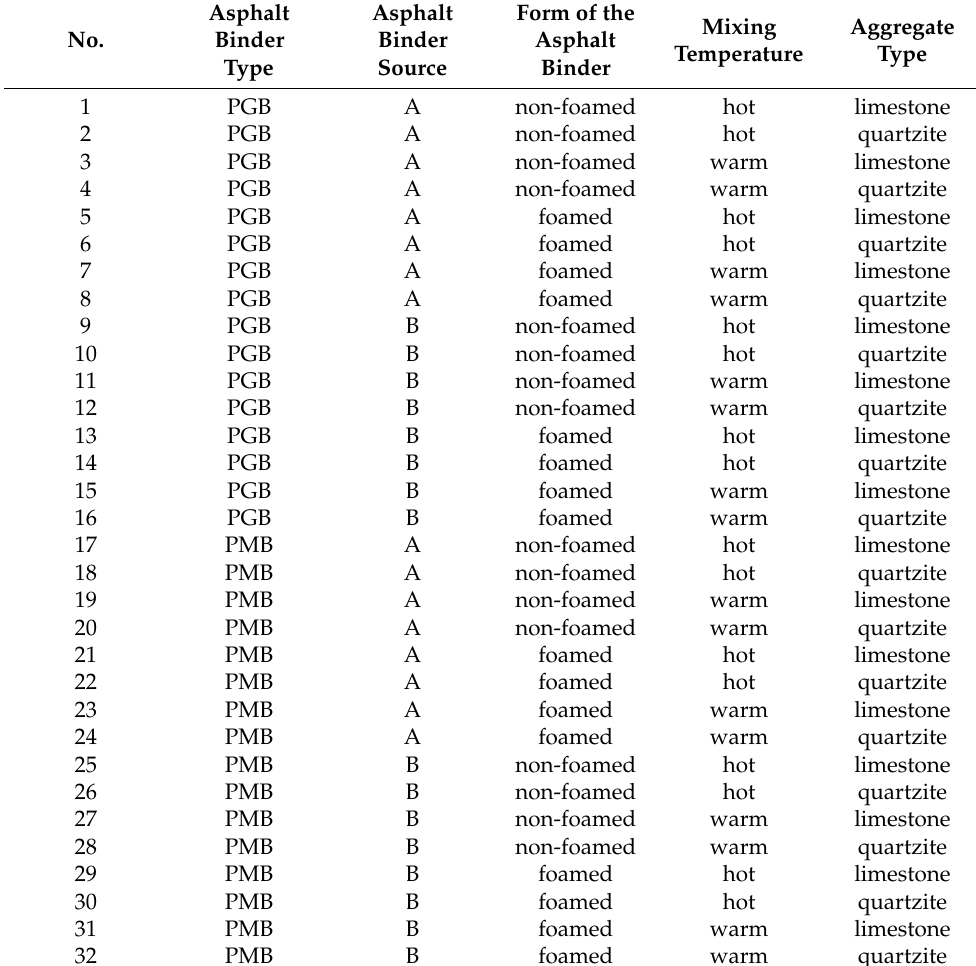
Table 1. Characterization of the paving-grade and polymer-modified bitumen used in the